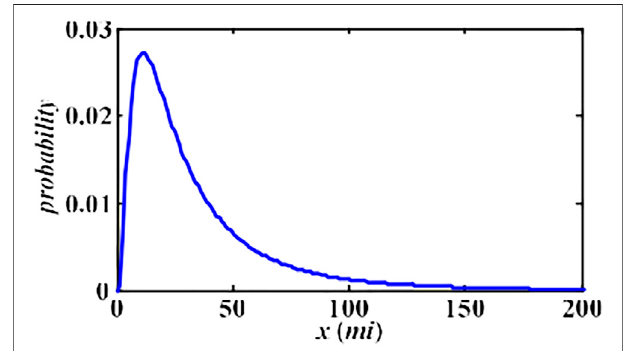
FIGURE 5 | Daily probability of driving distance.